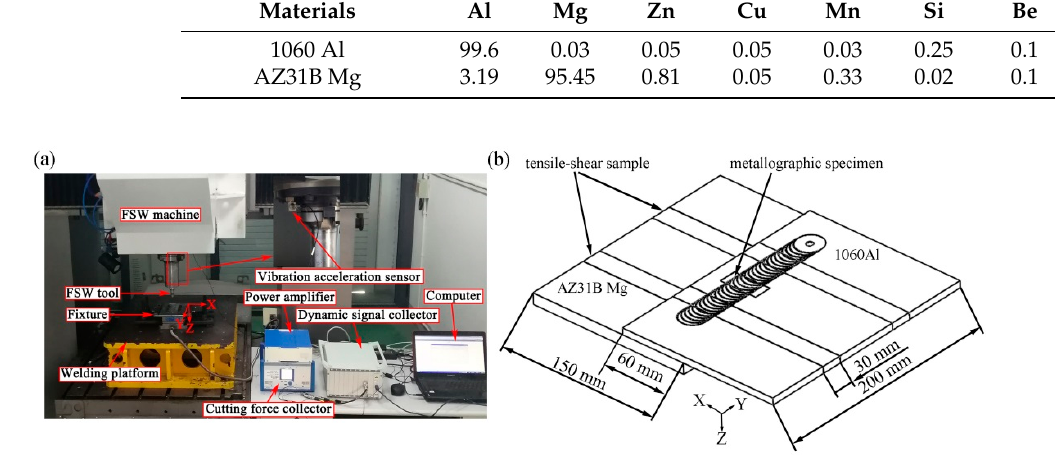
Figure 1. ( a ) Friction stir lap welding (FSLW) equipment. ( b ) Tensile shear testing and metallographic samples. Table 1. Chemical composition of 1060 Al and AZ31B Mg (wt.%).